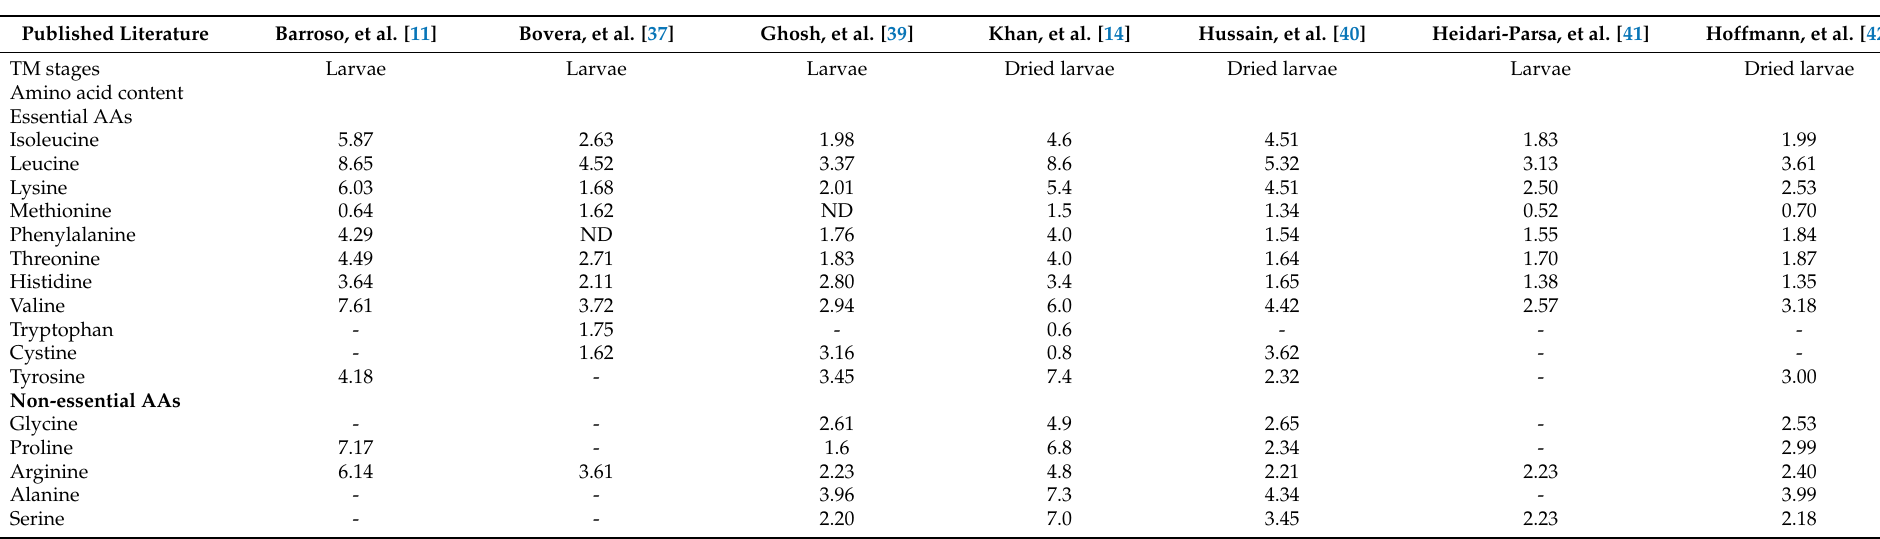
Table 2. Essential and non-essential amino acid (AA) content of the yellow mealworm ( Tenebrio molitor ) (g/100 g of protein) according to the previously published